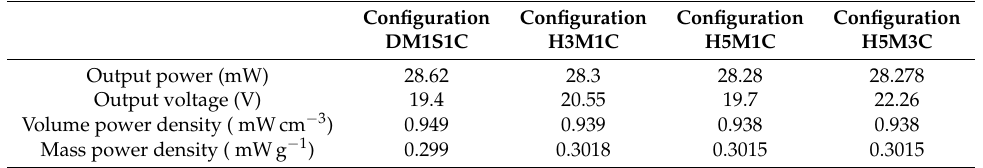
Table 7. Performance comparison of the different configurations after output power optimization.